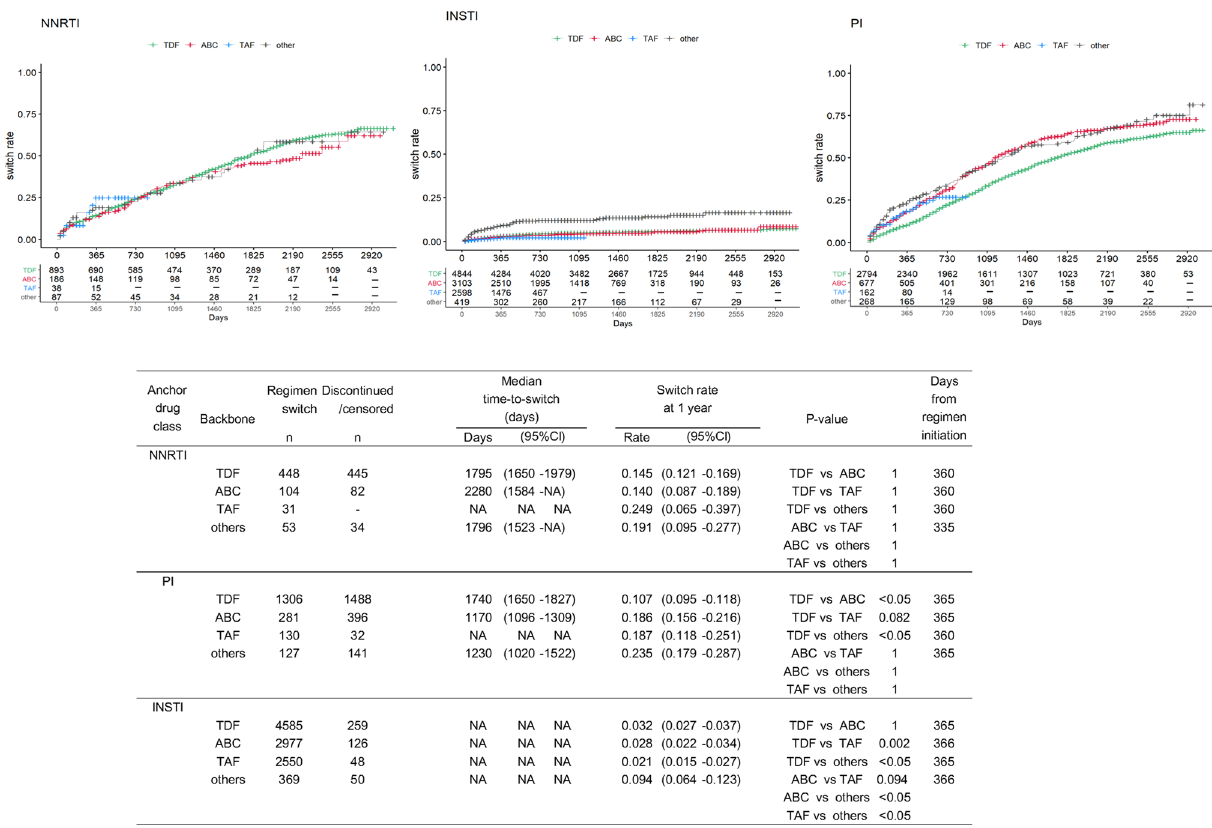
Figure 3. Time-to-switch of ART regimens by anchor drug class-based backbone type from 2011 to 2019. The median time-to-switch and switch rates of anchor drug classes were estimated by Kaplan–Meier analysis. Brookmeyer–Crowley and Greenwood methods were used to estimate 95% confidence intervals for switch rates and median days, respectively. Switch rates were compared between drug classes by using log-rank tests. The Bonferroni method was performed to adjust p values on multiple comparison. ART Antiretroviral therapy, NNRTI Non-nucleoside reverse transcriptase inhibitor, PI Protease inhibitor, INSTI Integrase strand